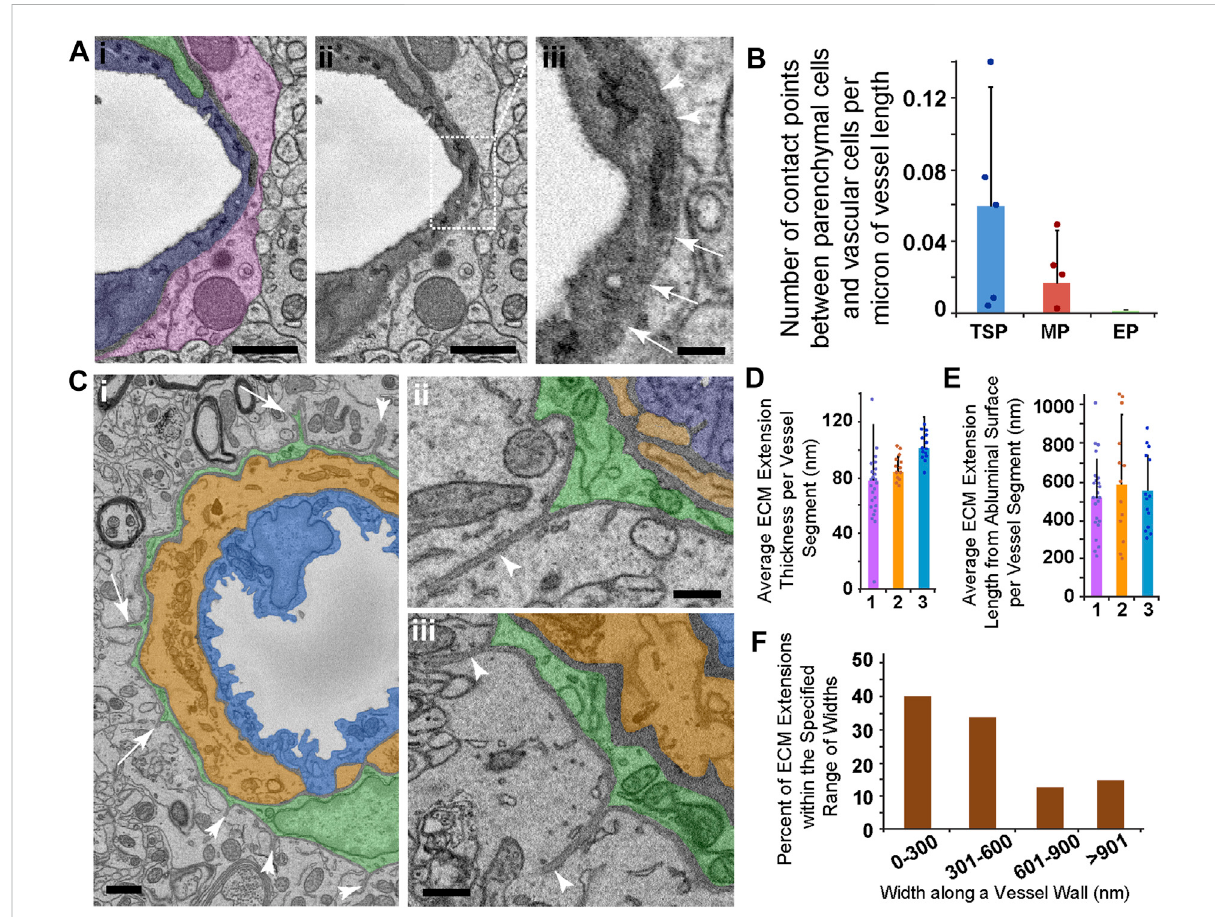
FIGURE 6 SEM Images and Quanti fi cation of Presumptive Parenchyma-Vessel Contact Points and ECM Extensions Emanating from Ensheathing PCs. (A) Representative SEM image of a thin-strand PC (green pseudo-color in i), associated EC (blue pseudo-color in i), and a surrounding parenchymal cell (pink pseudo-color in i). The same image in (i) is shown in (ii) to allow an unobstructed view of the vessel wall SEM. Dotted rectangle denotes a region shown at higher resolution in (iii). The region of interest shown in (iii) represents an area where a denser electron signal was observed along the outer vessel edge (arrowheads), but this signal became thinner along the circumference of the vessel edge (arrows), suggesting the potentialforcontactbetweenbrainparenchymaandthevessel.Scalebarsin(i)and(ii),1 μ m,andin(iii),250 nm. (B) Bargraphdisplayingtheaverage number of presumed contact points between brain parenchymal cells and vascular cells per micron of vessel length. Error bars denote standard deviations. (C) Representative SEM imagesof an ensheathing PC (green pseudo-colorin i-iii) with an underlying medial cell (orange pseudo-color in i-iii) and endothelial cell (blue pseudo-color in i-iii). Arrowheads in (i) denote ECM extensions into the surrounding brain parenchyma, and arrows note PC processes associated with ECM extensions found in consecutive images. Images shown in (ii) and (iii) are additional examples of ECM extensions ofvariouslengths, also with associated PC cytoplasm attheir base. Scale barin (i),1 μ m,and in(ii) and (iii),500 nm. (D) Bar graph showing theaverageECMextensioncross-sectionalthicknessperEP-associatedvesselsegment(n=3)innanometers.Errorbarsdenotestandarddeviations. (E) Bar graph showing the average ECM extension radial length per EP-associated vessel segment (n = 3) in nanometers. Error bars denote standard deviations. (F) Percent of ECM extensions within the speci fi ed range of widths: 0 – 300 nm, 301 – 600 nm, 601 – 900 nm, and greater than 901 nm “ Widths ” represent the distance along the primary vessel axis where an ECM extension was detected. A total of n = 12 vessels were analyzed from n = 10